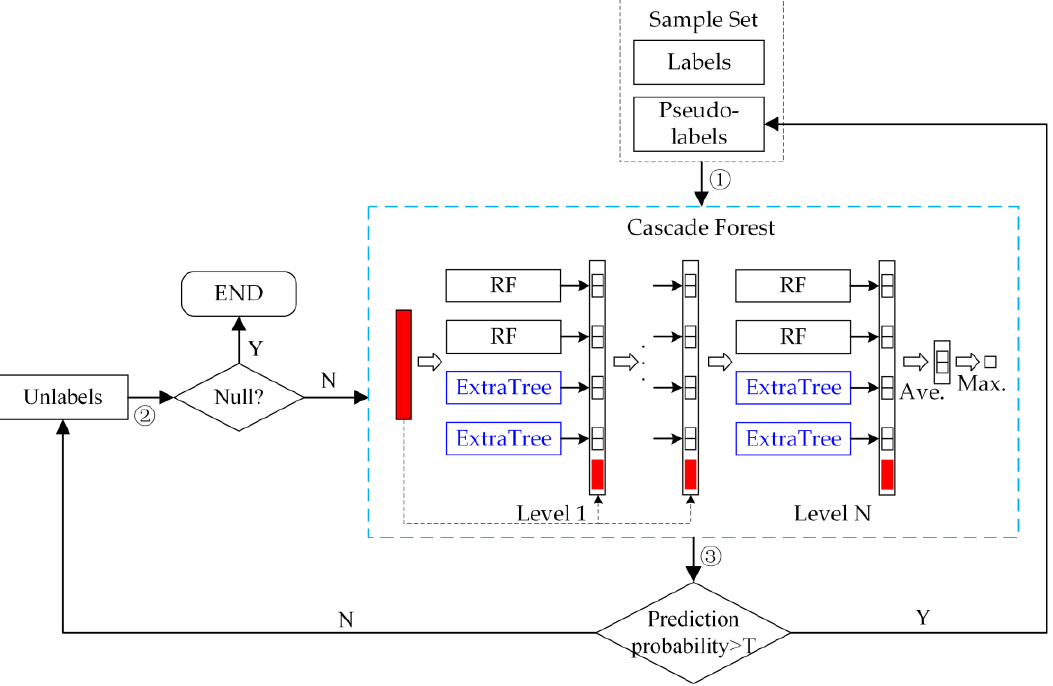
Figure 2. An overview of the proposed STDF .